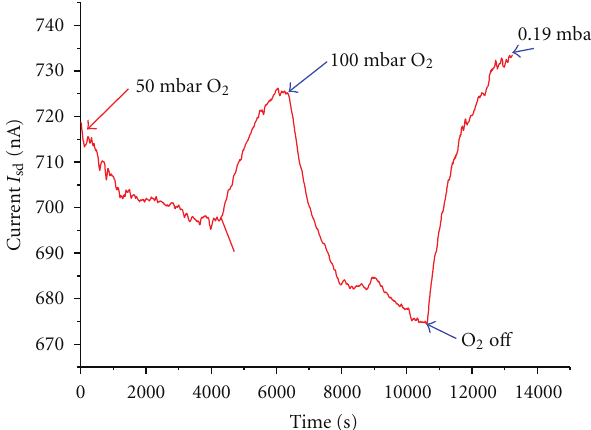
Figure 11: Sensing response of anodized Ti NWFET at di ff erent partial pressures of oxygen. A pronounced answer is visible.